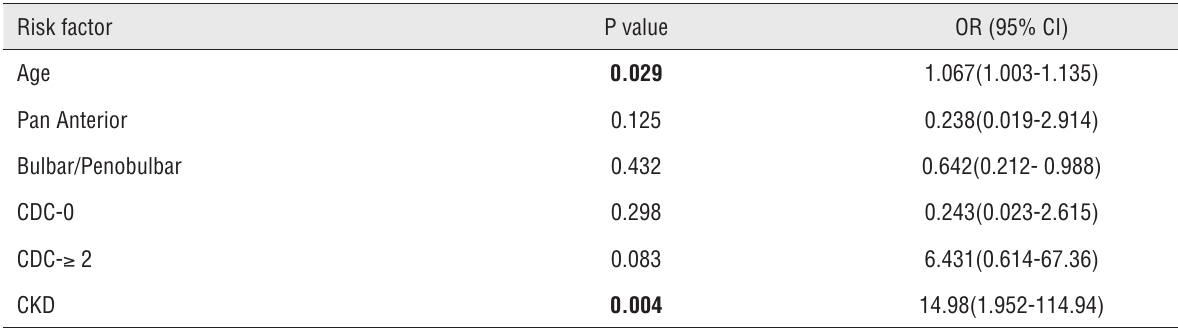
Table 2 - The multivariate logistic regression analysis for risk factors associated with stricture